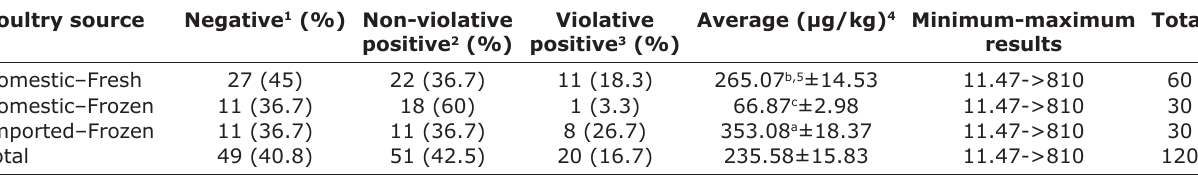
Table-2: Numbers (%) of sulfamethazine negative, non-violative positive, and violative positive in poultry samples. Poultry